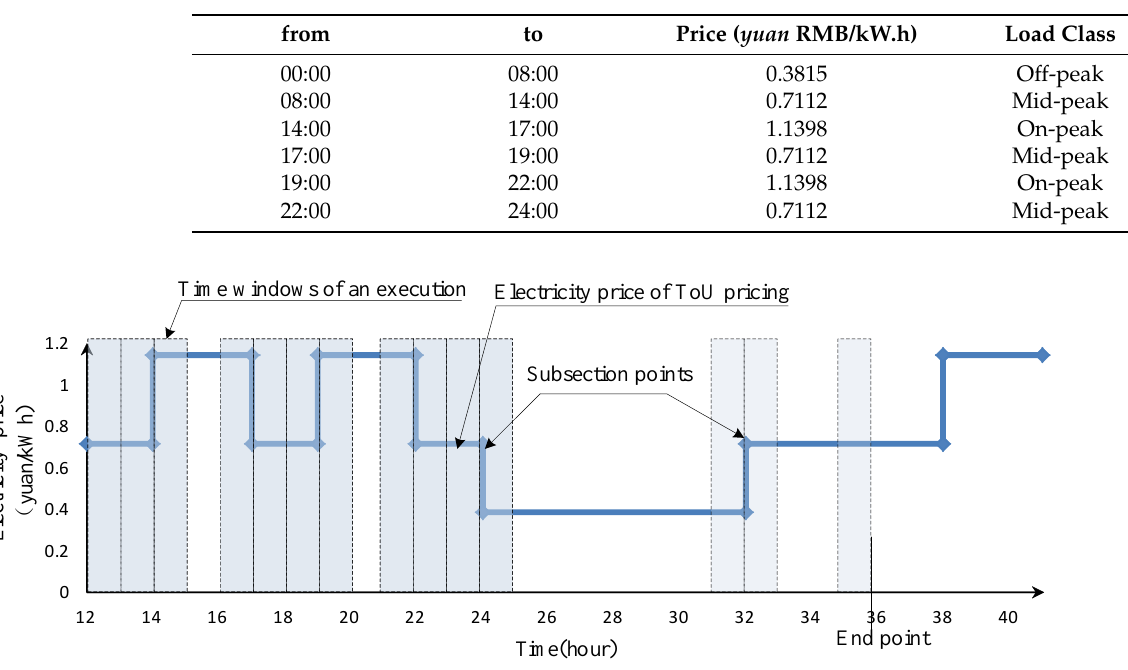
Figure 6. Candidate set of operation times of an execution example. In Figure 6, the horizontal axis denotes the time in increments from the enabled time 12:00, the vertical axis denotes the electricity price, the line denotes the electricity price of ToU pricing and the rectangles filled with color denote the time window of execution. The subsection points (12, 14, 17, 19, 22, 24, 32, 36) can be found on the line. The first candidate operation time is just the enabled time 12:00. Then, the time window is moved right to the end point (the value 36 means 12:00 after 24 h). When the left or right end